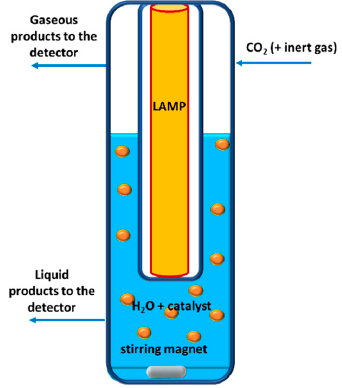
Figure 3 . Example of a three ‐ phase photoreactor for CO 2 photoreduction. Figure 3. Example of a three-phase photoreactor for CO